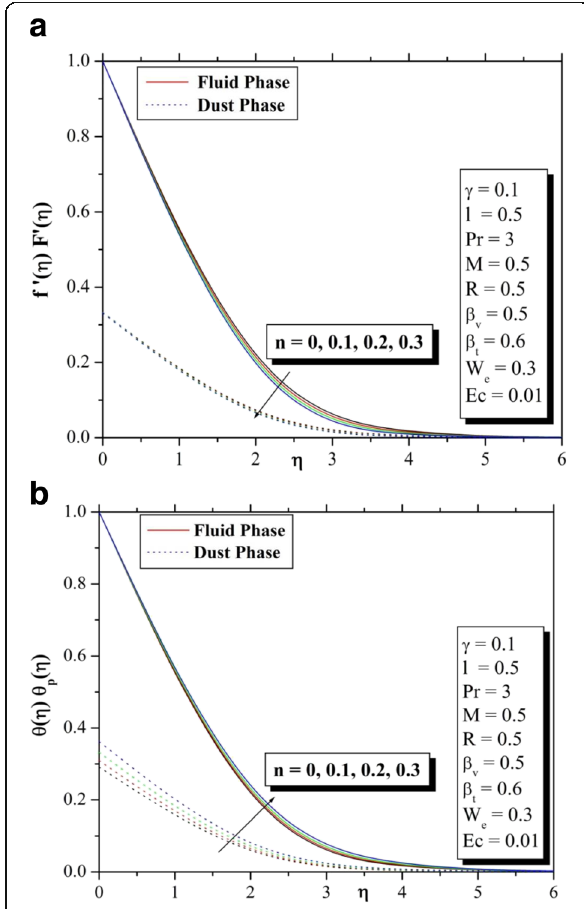
Fig. 4 a , b Velocity profile and temperature profile for different values of M